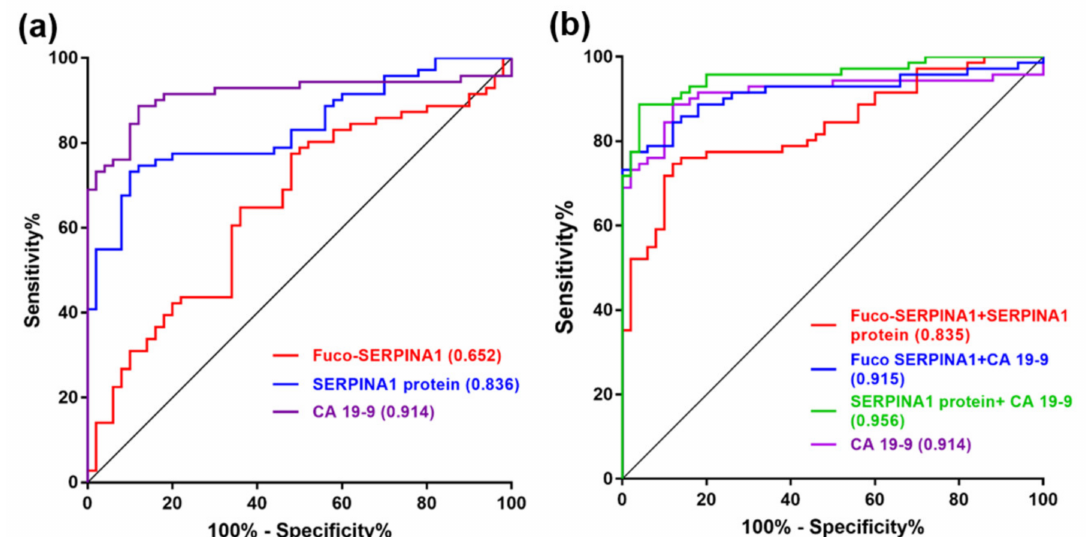
Figure 7. ROC curve analysis of fuco-SERPINA1, SERPINA1 protein and CA19-9 in discriminating PC patients from GS subjects. ( a ) The discriminatory power of plasma fuco-SERPINA1, SERPINA1 and CA19-9 was evaluated via ROC curve analysis. ( b ) The discriminatory power of combined fuco-SERPINA1 with SERPINA1 or CA19-9 was further evaluated. AUC values are presented in